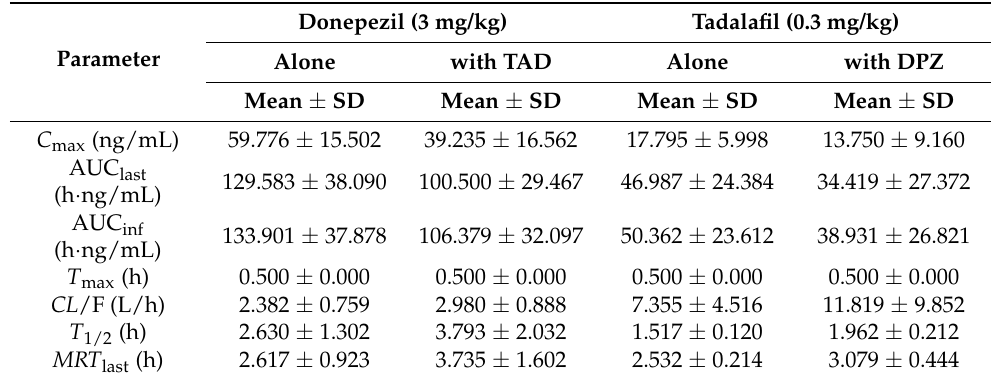
Figure 3. Mean plasma concentration–time curves of ( A ) donepezil (3 mg/kg, ○ : single dose, ● : combined with tadalafil) and ( B ) tadalafil (0.3 mg/kg, △ : single dose, ▲ : combined with donepezil) in PK tests ( n = 3). Table 4. Pharmacokinetic parameters of donepezil and tadalafil in rat plasma after oral administration of a single dose and combined doses ( n =